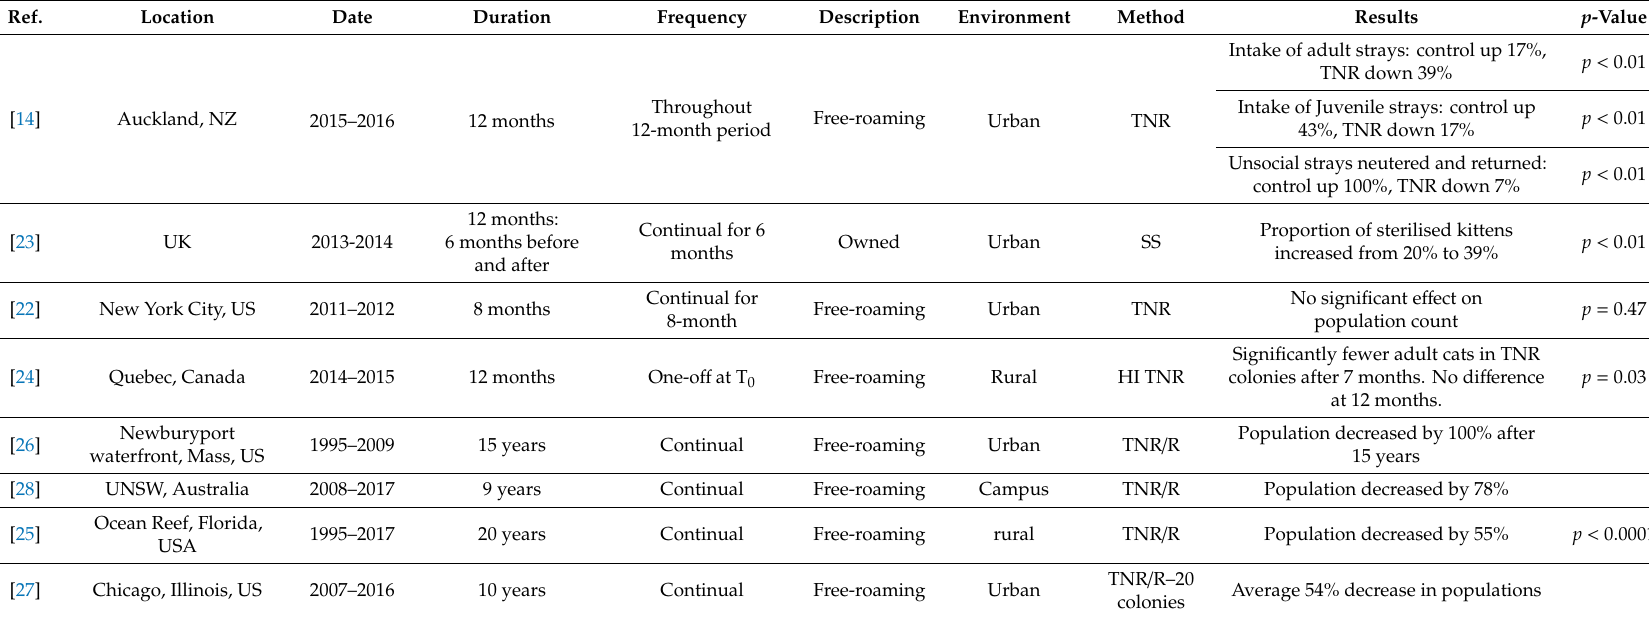
Table 2. Results from eight articles where a cat population management strategy was implemented in a field environment.